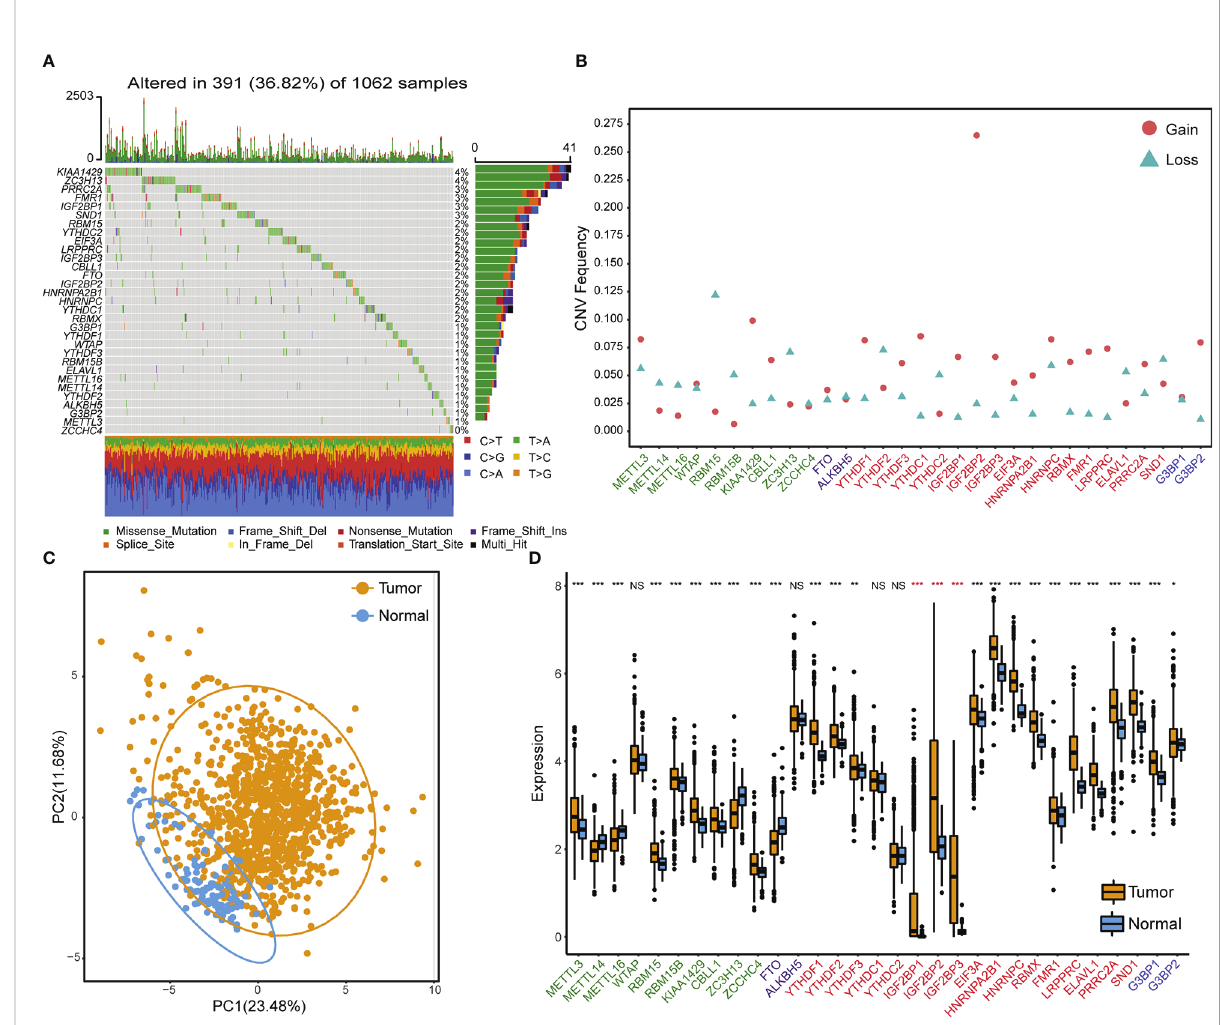
FIGURE 1 Genetic and transcriptional variation landscapes of RNA m 6 A modi fi cation regulator genes in the TCGA dataset. (A) The frequency of mutations and the distribution of mutation types of m 6 A regulator genes in NSCLC tissue samples. (B) The frequency of m 6 A regulator gene copy number variation in NSCLC tissue samples. Blue triangles denote deletion and red dots denote ampli fi cation. (C) Principle component analysis results to distinguish NSCLC samples from adjacent normal tissues based on the expression of m 6 A regulator genes. (D) The expression pro fi le of m 6 A regulator genes in cancer samples and adjacent normal samples. Asterisks in red indicate genes belonging to the IGF2BPs family. NS p > 0.05; * p < 0.05; ** p < 0.01; *** p <